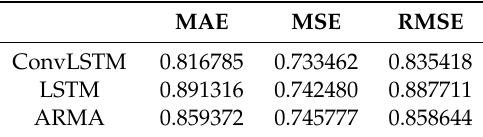
Table 3. Moran’s I indices of the spatial distribution of the three methods. LSTM—long short-term memory; ConvLSTM—convolution LSTM; ARMA—autoregressive moving average; MAE—mean absolute error; MSE—mean squared error; RMSE—root-mean-squared error. MAE MSE RMSE ConvLSTM 0.816785 0.733462 0.835418 LSTM 0.891316 0.742480 ARMA 0.859372 0.745777